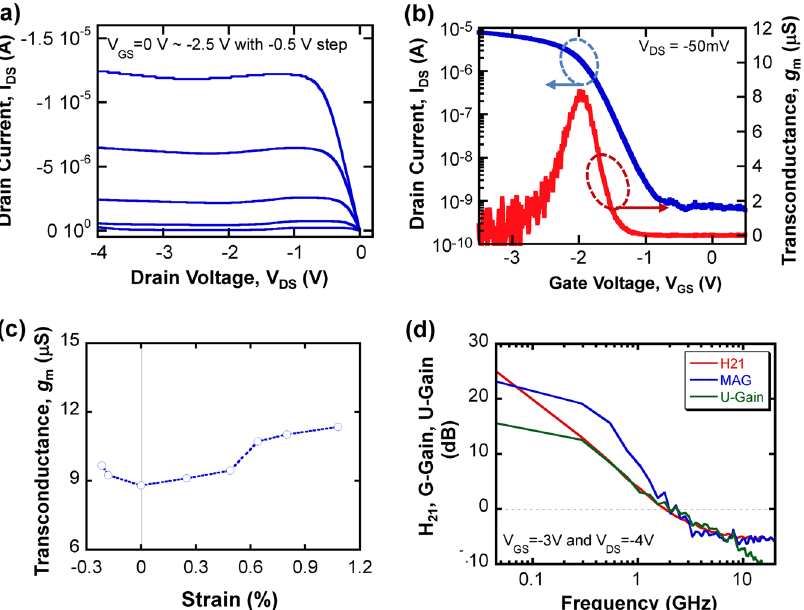
Fig. 4 Device characteristics of PMOS TFT a Drain current ( I DS ) – voltage ( V DS ) characteristics with different V GS values ranging from 0 V to − 2.5 V with 0.5 V increments. b Drain current ( I DS ) and transconductance ( g m ) curves with a drain bias of 50 mV and a V GS ranging from 0.5 V to − 3.5 V. c Transconductance ( g m ) with respect to applied strain at a fi xed voltage bias point of V GS = − 1 V and V DS = − 3 V. d Current gain ( h 21 ) and unilateral power gain ( U -gain) as a function of frequency from 45 MHz to 20 doping concentration and their pro fi les based on the actual for the source/drain regions in NMOS and the emitter/collector parameters used for the ion implantation process. Figure 2c show regions in NPN BJT. Finally, the sample was annealed to diffuse the detailed plots of the doping pro fi les from NMOS, PMOS and and recrystallize the Si NM. In total, only three ion implanations NPN BJT, respectively. and two thermal annealing steps were used for the entire Electrical characterizations of the NMOS and PMOS TFTs are fabrication of all three types of transistors. The fi nished PMOS/ shown in Figs. 3 and 4, respectively. The physical gate length, gate NMOS and BJT are shown in Fig. 1b, c. Figure 1d shows the bent width ( W g ), and effective gate (channel) length ( L g ) of NMOS and image of the fl exible BiCMOS chip. Figure 2b shows the simulated